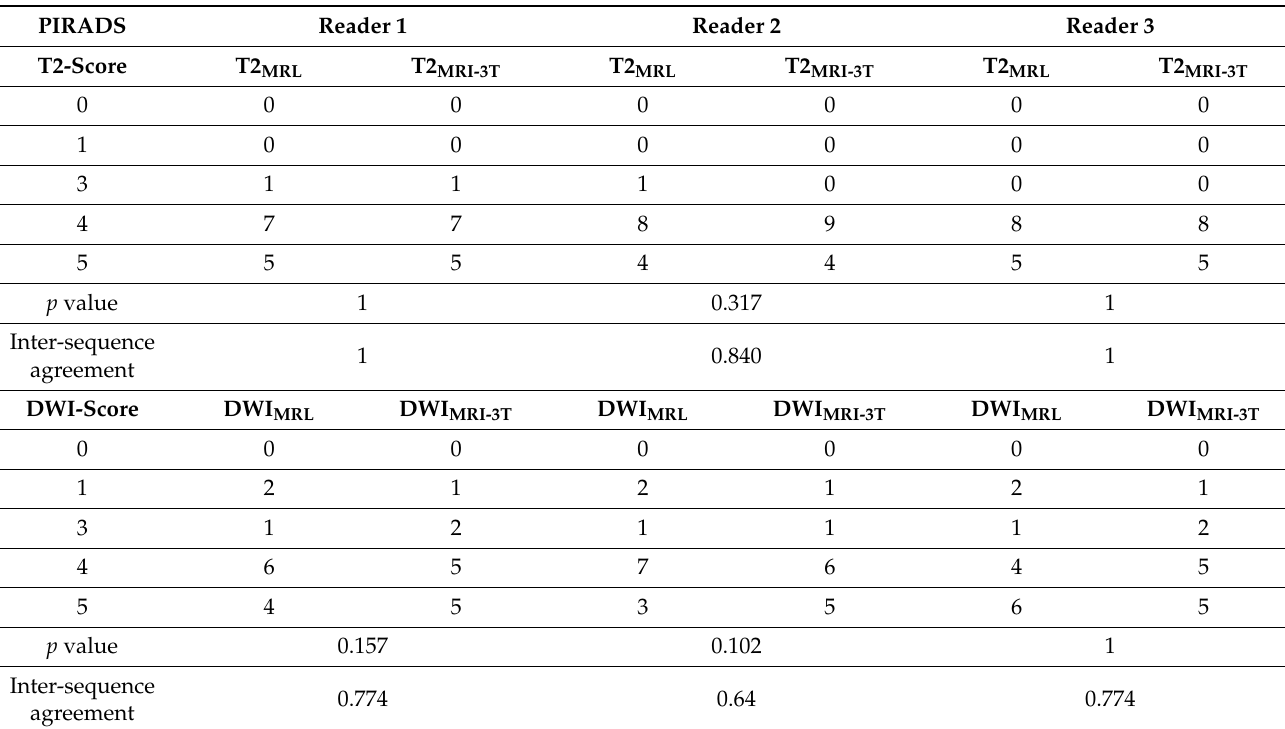
Table 7. Comparison of T2w- and DWI- PIRADS score between MRL and MRI3T for each reader as well intersequence agreement between MRL and MRl3T for each